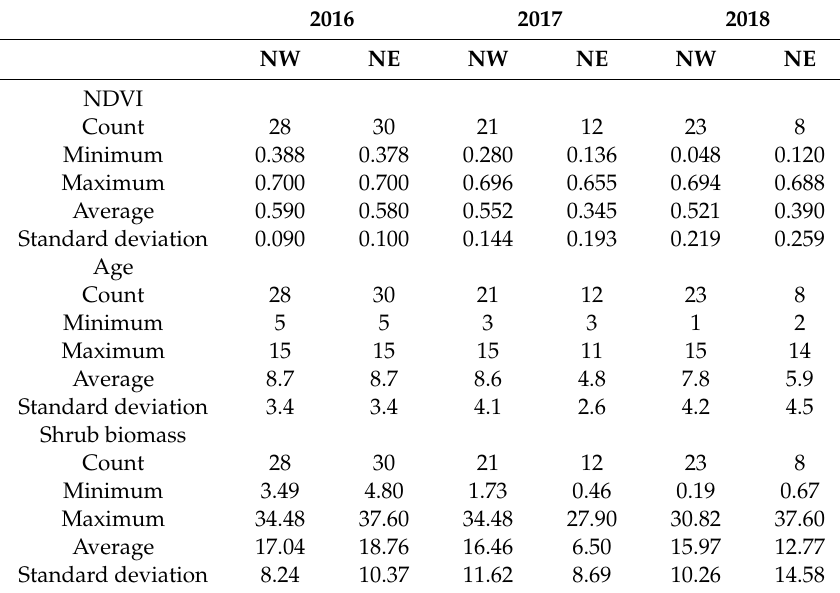
Table 3. Descriptive statistic for the